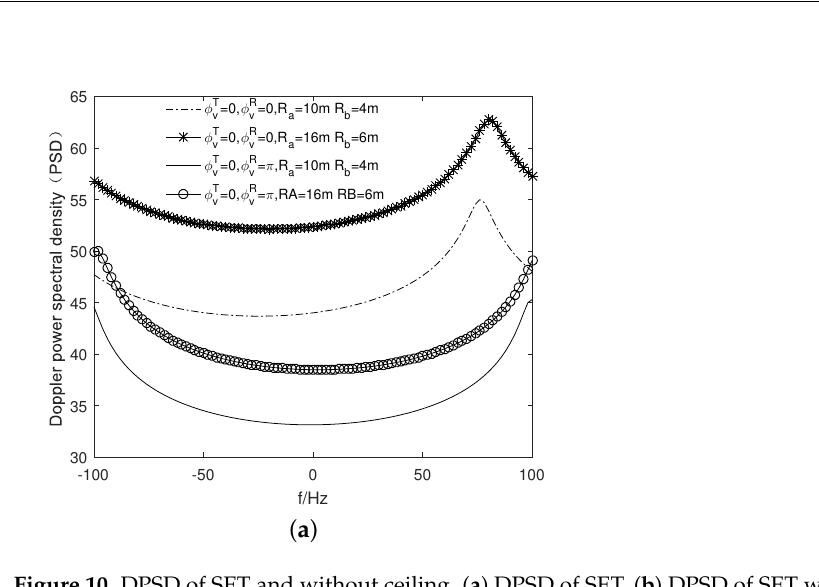
Figure 10. DPSD of SET and without ceiling. ( a ) DPSD of SET. ( b ) DPSD of SET without ceiling.